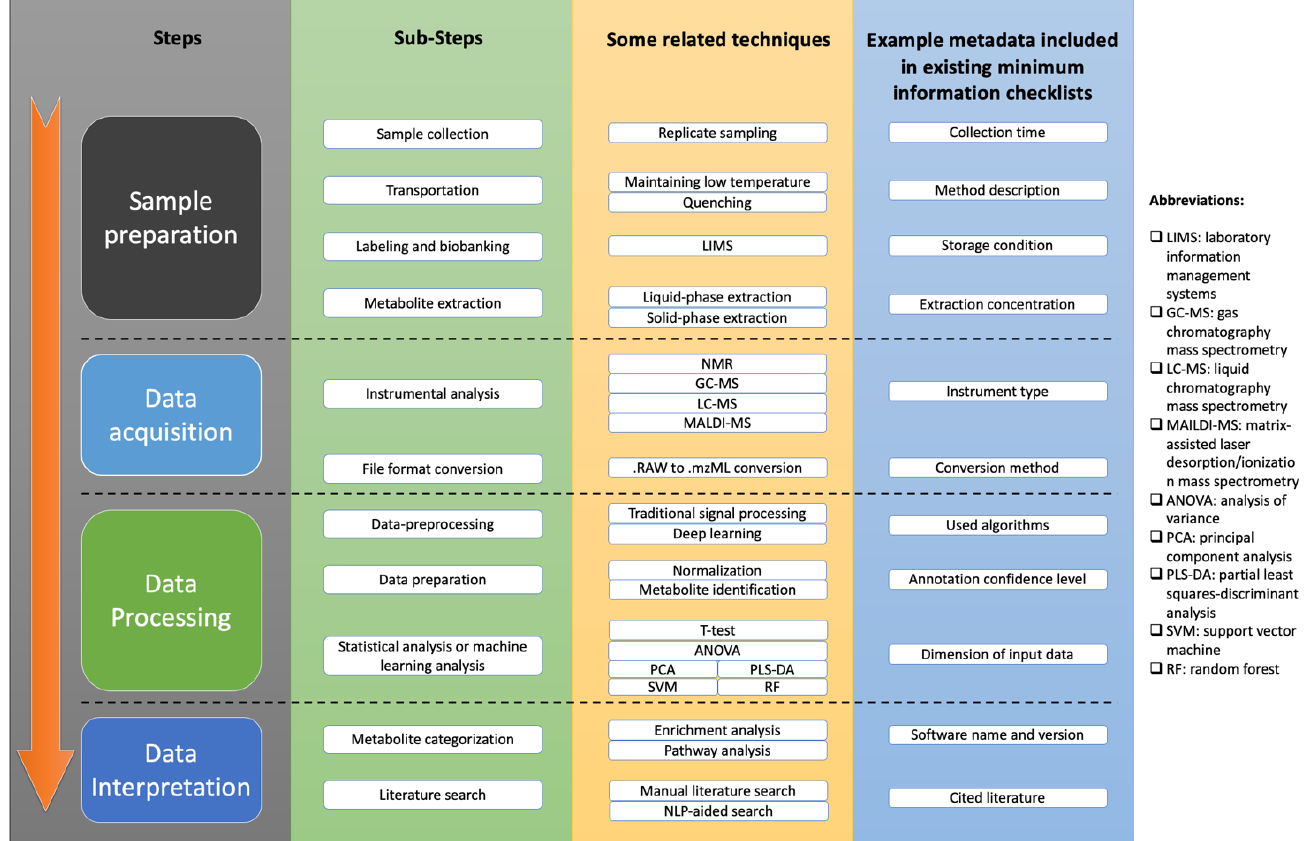
Figure 1. Overview of metabolomics study workflow. Workflow includes steps of sample preparation, data acquisition, data processing, and data interpretation. Each step has multiple substeps, and each substep has several techniques that can be used. Minimum information checklists were proposed to guide metadata reporting for purpose of reproducibility improvement. Some example items included in existing minimum checklists are shown in blue column of figure.